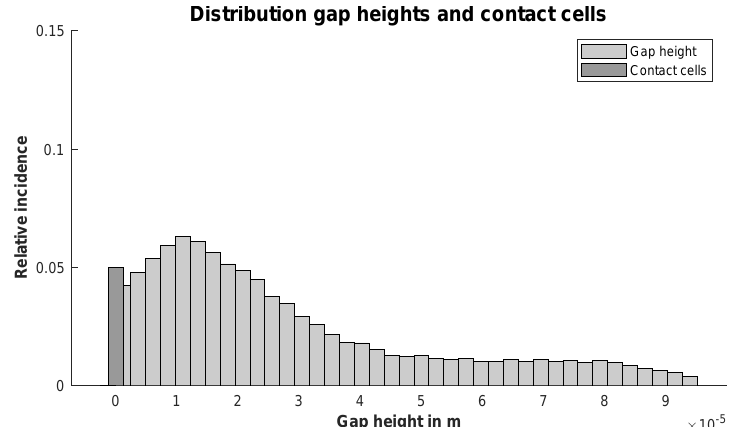
Figure 17. Distributions of deformed gap heights in the upwards-facing topography.